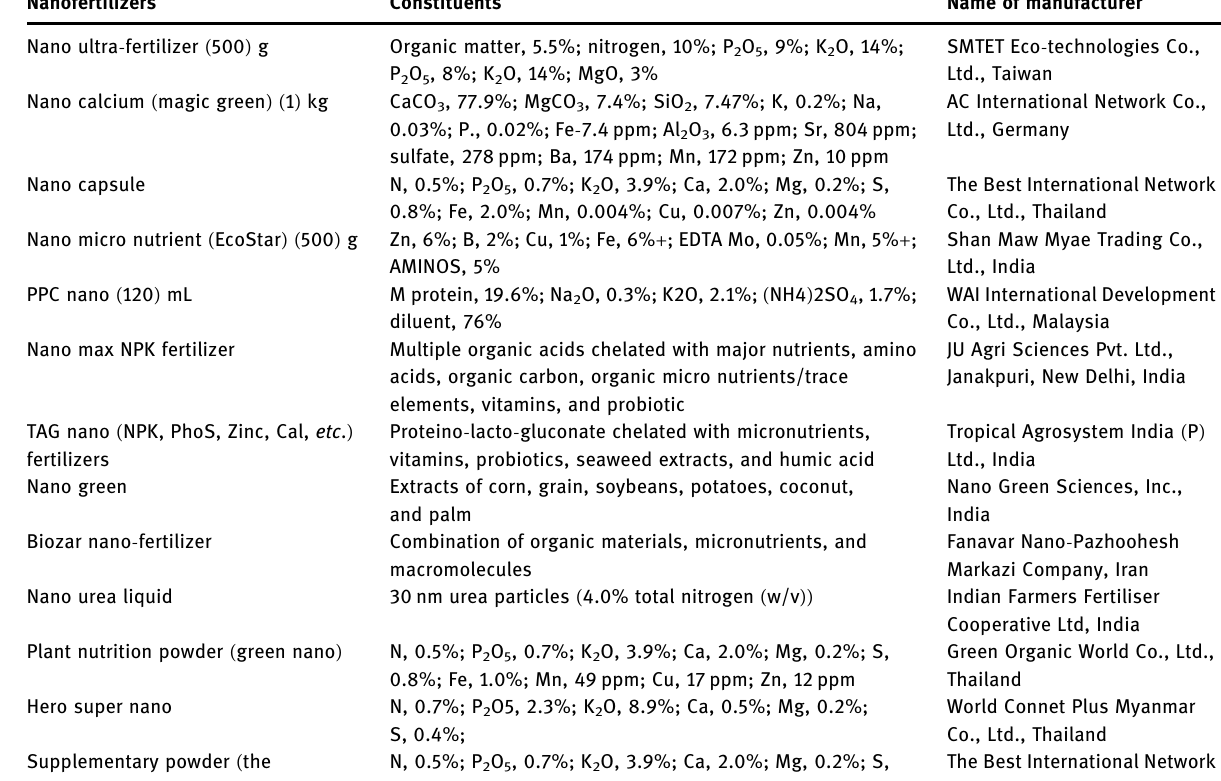
Nanofertilizers